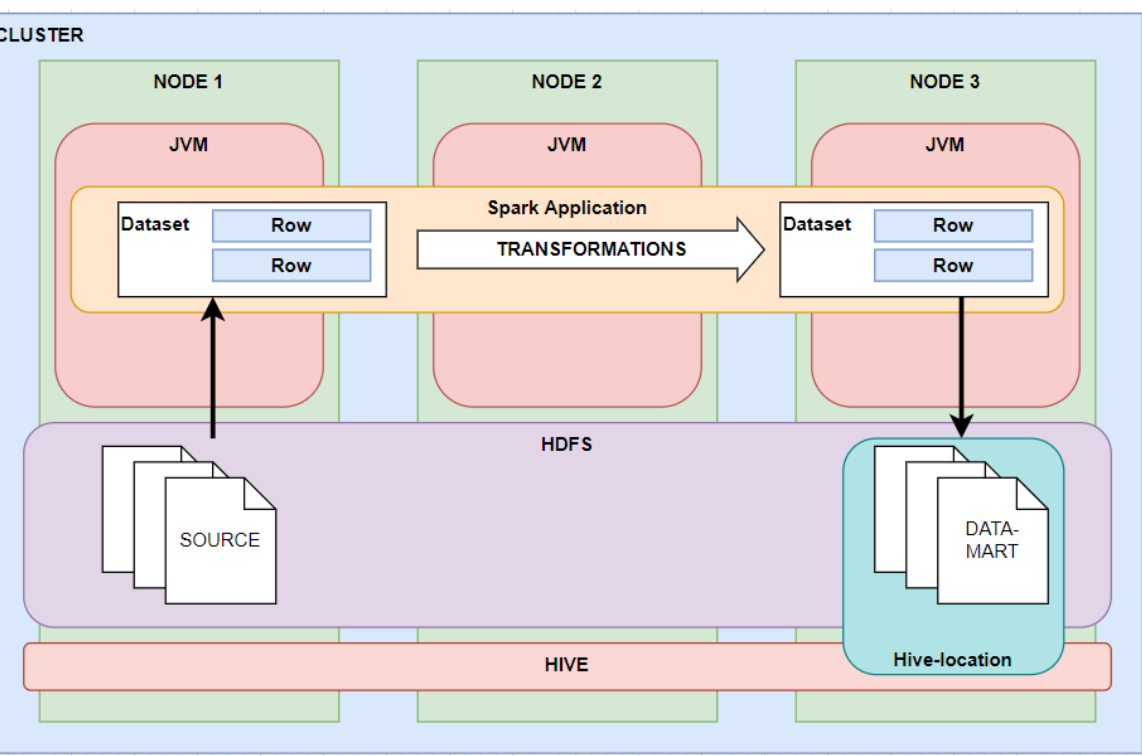
Figure 5. Schema of the experiment.